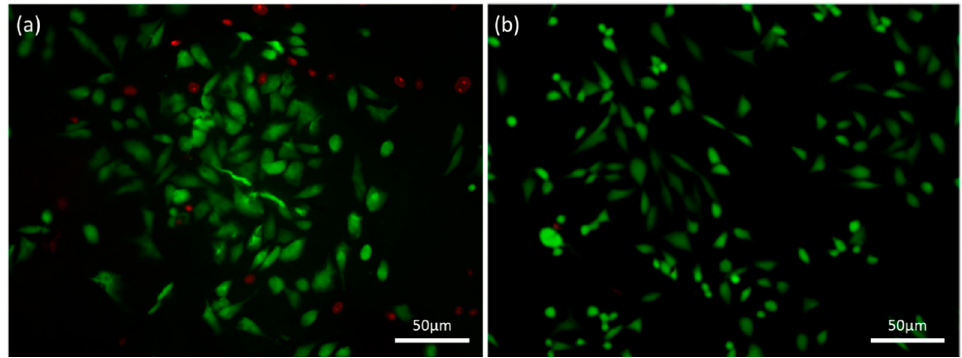
Figure 11. FDA/PI staining on ( a ) a HAp-Col-Arg scaffold crosslinked with 0.01% riboflavin (184 cells Figure 11. FDA / PI staining on ( a ) a HAp-Col-Arg sca ff old crosslinked with 0.01% riboflavin (184 cells